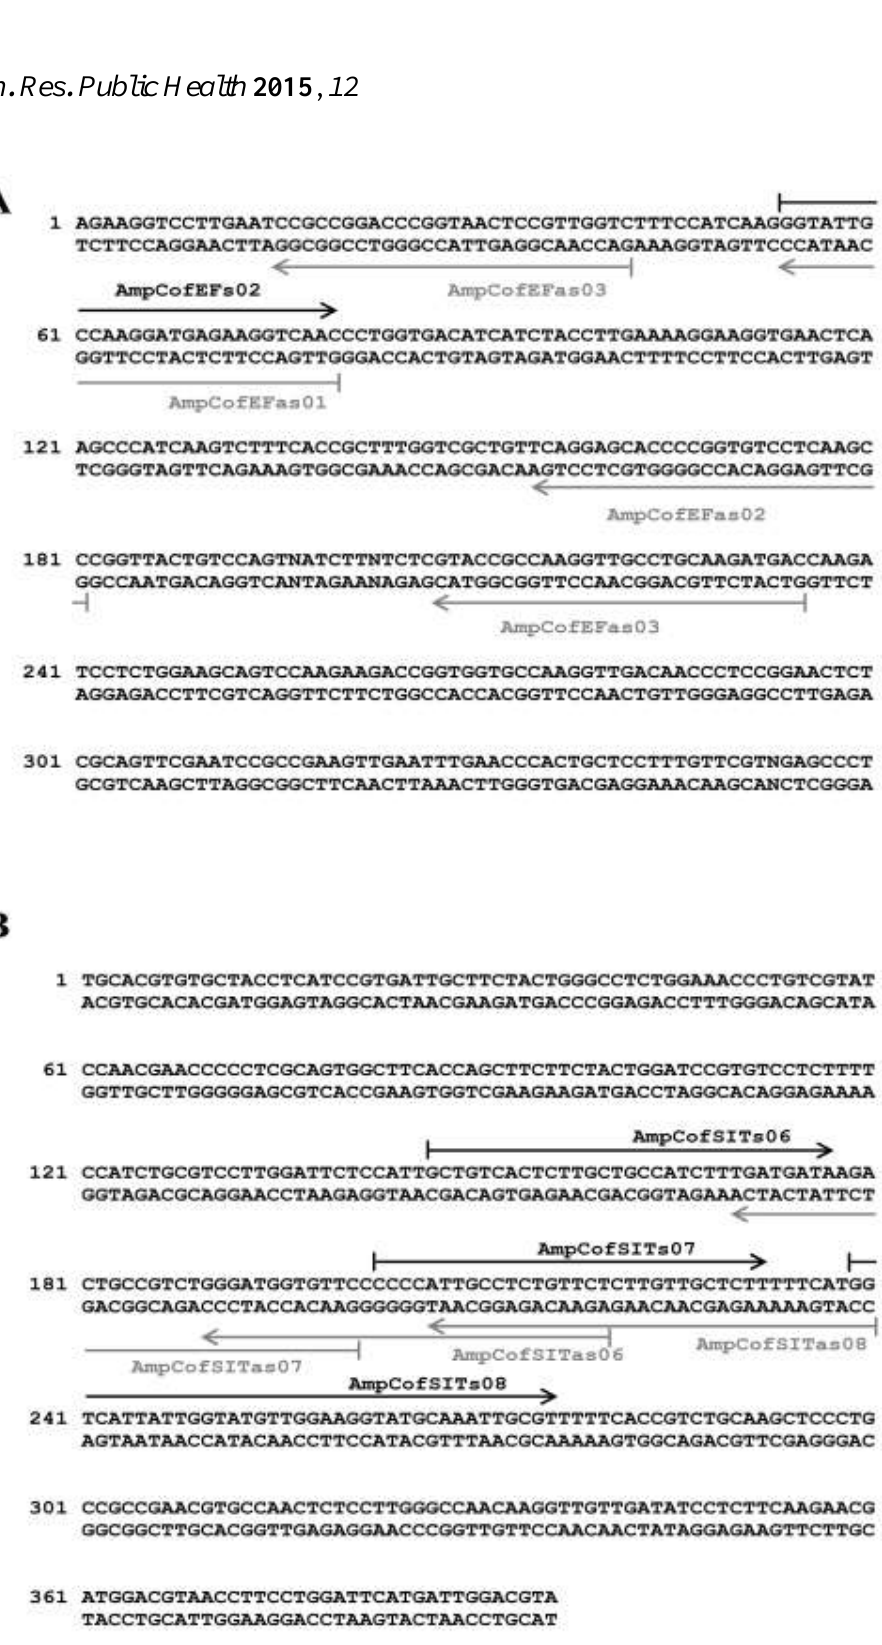
Figure 5. DNA sequence of the fragments of elongation factor eEF1-a ( A ) and SIT ( B ) obtained by PCR amplification from Amphora coffeaeformis chromosomal DNA. The sense and anti-sense probes specifically designed on this sequence and used for microarray analysis are indicated with black arrows and grey arrows,